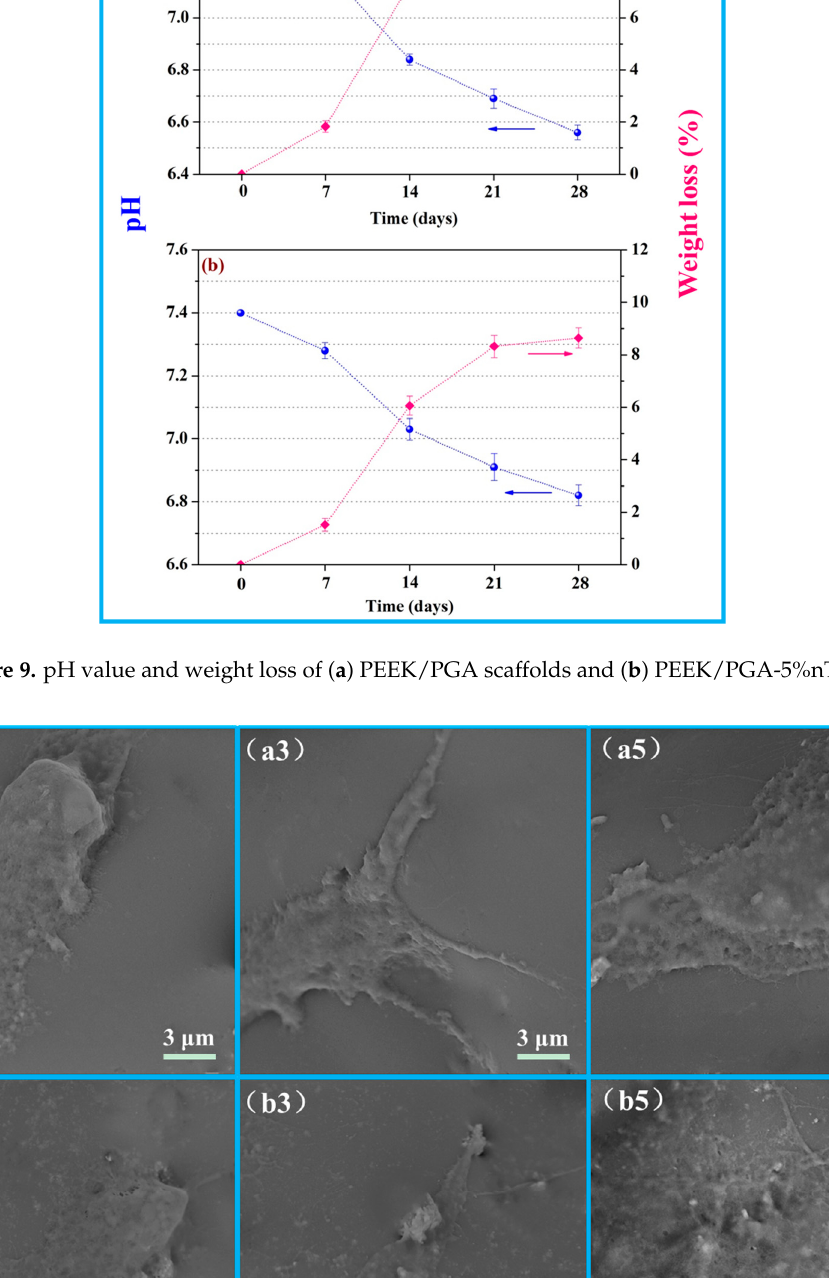
Figure 11. Fluorescence microscopy images (live cells appeared as bright green dots and related cytoblast as purplish blue dots) of MG ‐ 63 cells on ( A – C and a – c ) PEEK/PGA and ( D – F and d – f ) PEEK/PGA ‐ 5%nTiO 2 scaffolds after culture for 1, 3, and 5 days.